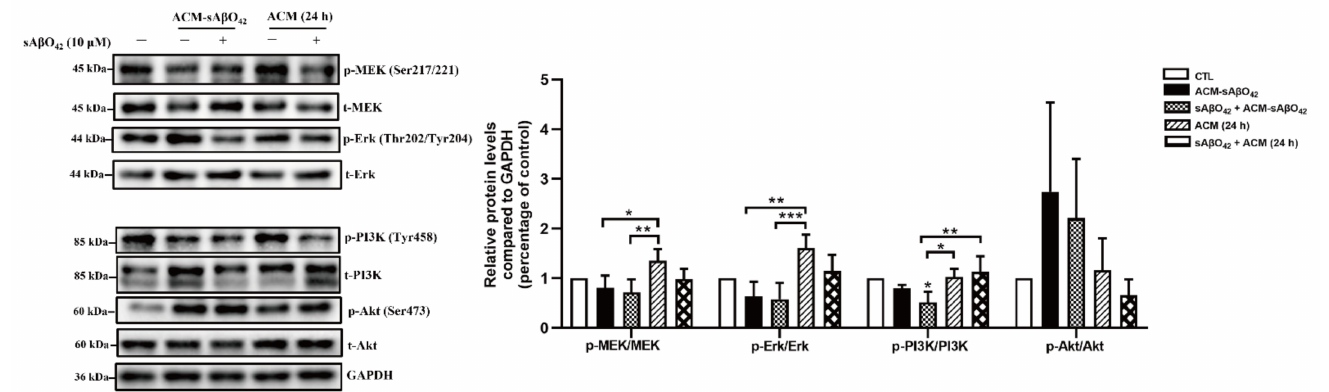
Figure 12. Resting ACM and ACM-sA β O42 had opposite effects on the VEGFR2 downstream pathways. The expression levels of proteins (pMEK/MEK, pErk/Erk, pPI3K/PI3K, and pAkt/Akt) in VEGFR2 downstream pathways in bEnd.3 cells. Data are shown as means ± SD of at least three independent experiments and were analyzed by one-way ANOVA followed by a post hoc Dunnett’s test and a post hoc Tukey’s test. * p ≤ 0.1, ** p ≤ 0.01, *** p ≤ 0.001 vs. control group or between two compared